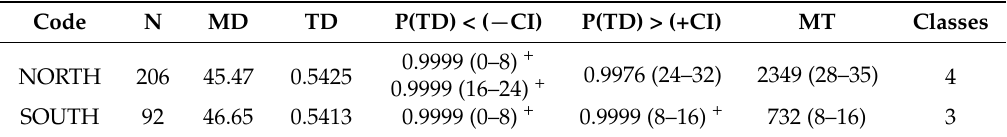
Table 4. Analysis of spatial genetic structure among seed stands of Pinus leiophylla by considering a distance class width of 8 km in the seed stands, 999 permutations, and a 99% confidence interval. The Tanimoto distance ( TD ) was calculated using Spatial Genetic Software 1.0 [5].